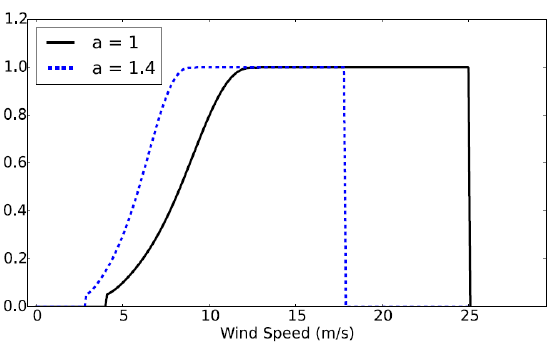
Figure A2. Power curve of a Vestas-90-2MW Turbine with normalized